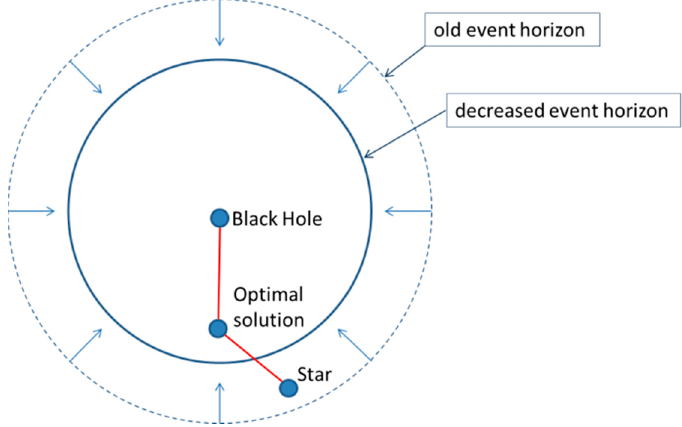
Figure 9. The permanently decreased Schwarzschild radius prevents the absorption of stars near the event horizon.